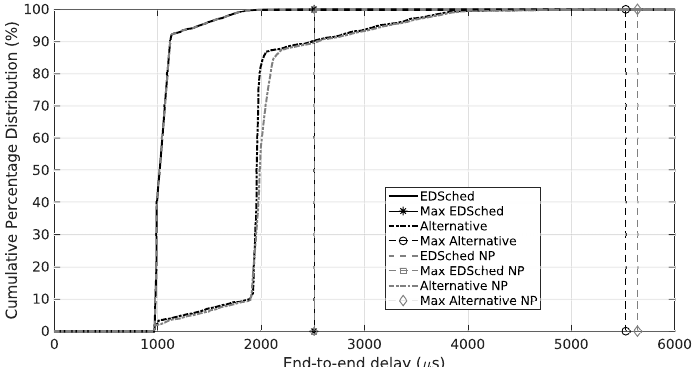
Figure 5. CaseA-Event-drivendelaycumulativepercentagedistributionwithandwithout(NP)preemption.